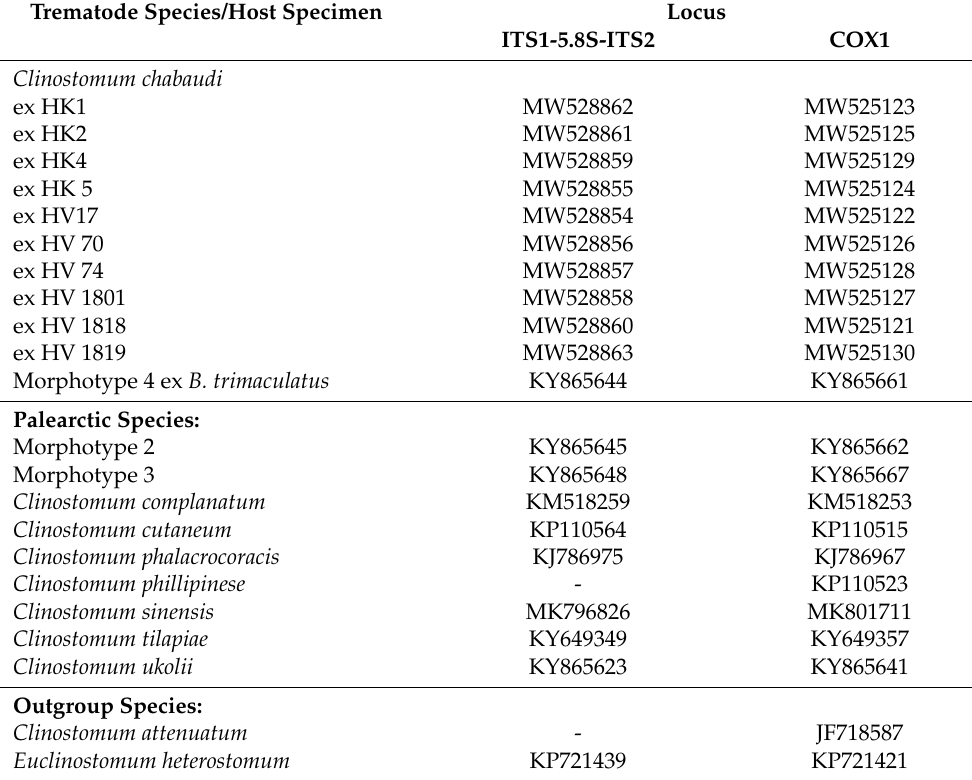
Table 2. Accession numbers of nuclear ribosomal sequences and mitochondrial COX1 sequences used for phylogenetic reconstruction. Reed frog hosts and their individual collection number: HK = Hyperolius kivuensis ; HV = H. viridiflavus . Original references to sequences from palearctic Clinostomum retrieved from GenBank and used for comparison are